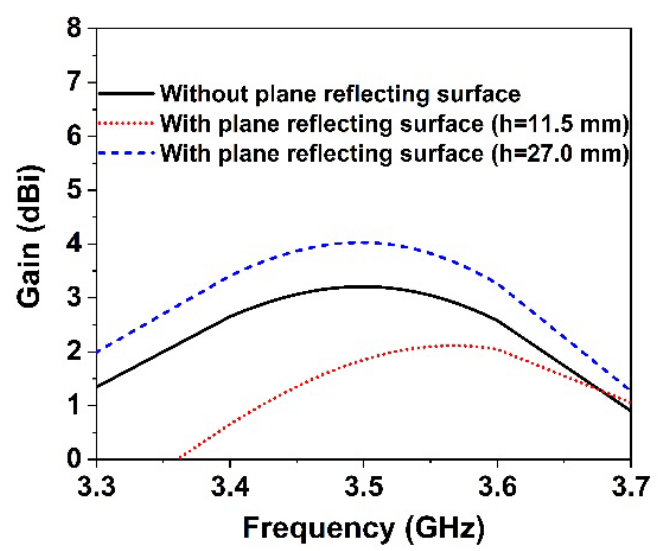
Figure 18. Gain comparison curve of the proposed antenna without and with plane reflecting surface.